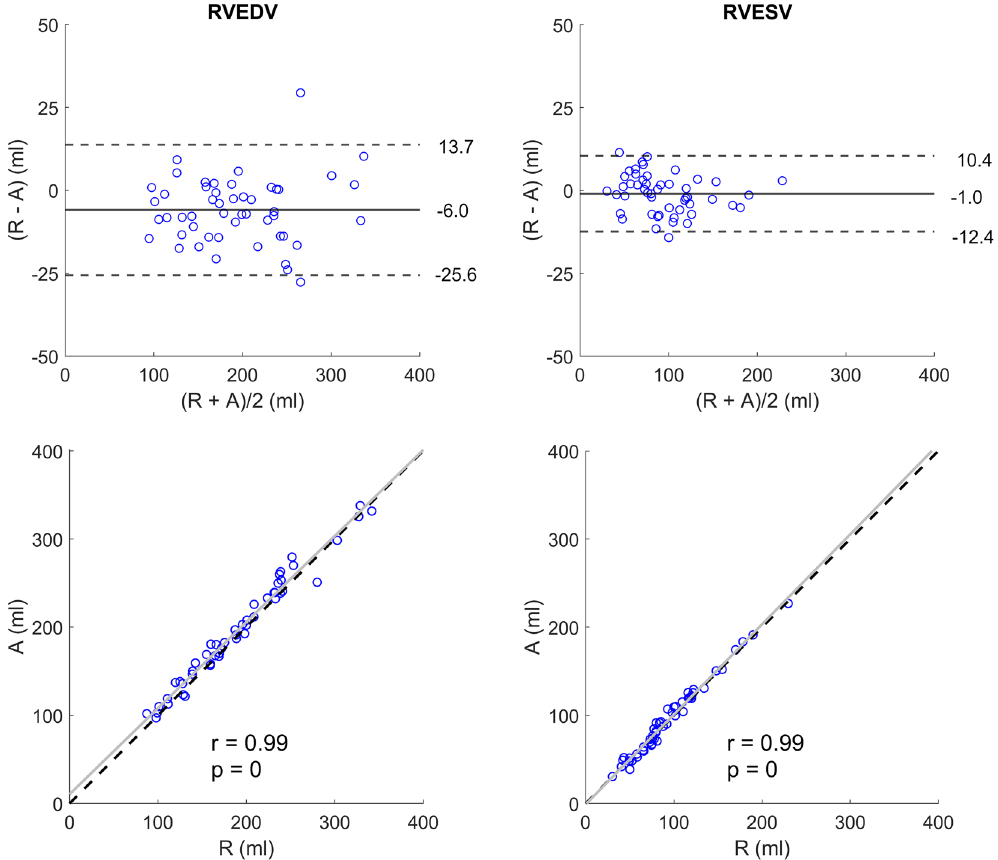
Figure 3. Bland–Altman and correlation plots between the pipeline’s automated (A) and the reference (R) RVEDV (left column) and RVESV (right column) on the clinical validation set (CVS). The Bland–Altman plots contain bias (full lines) and limits of agreement (± 1.96 SD, dashed lines). The correlation plots contain identity lines (black, dashed lines), least squares lines (grey, full lines), Spearman’s rank correlation coefficients (r), and corresponding p